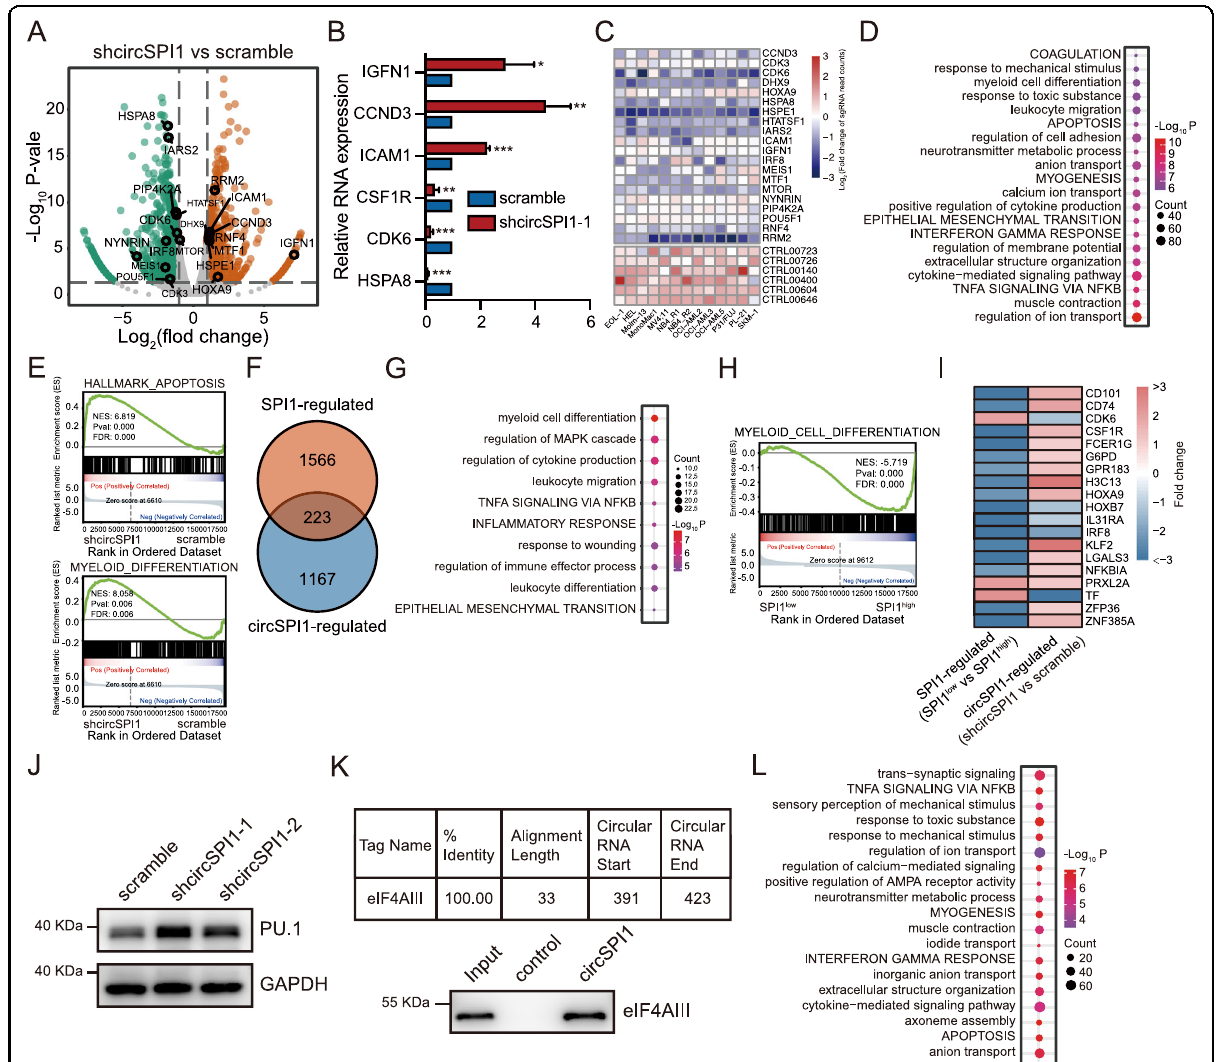
Fig. 4 CircSPI1 antagonizes SPI1 to modulate myeloid differentiation. A Volcano plot of differentially expressed genes after circSPI1 knockdown. The vertical lines correspond to 2.0-fold up and down, and the horizontal line represents a P value of 0.05. B The expression changes of